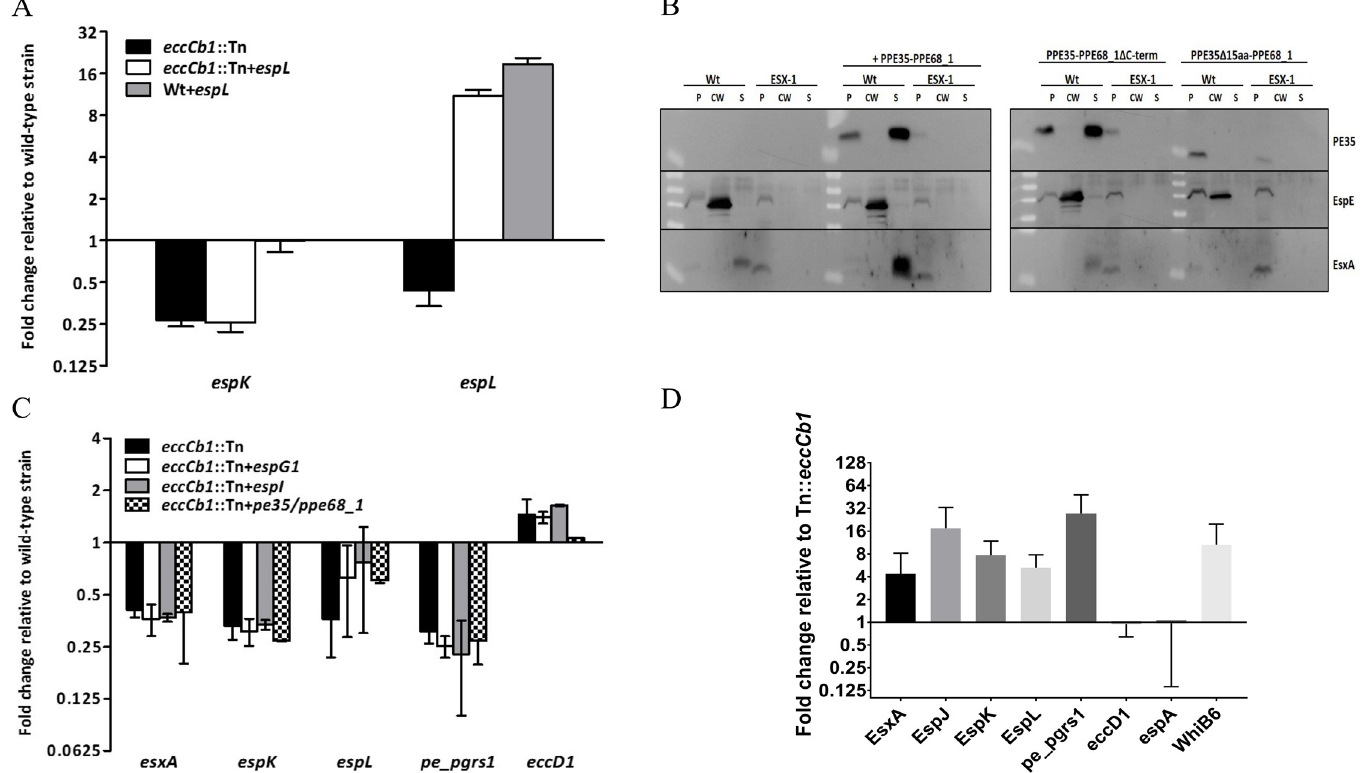
Fig 5. Regulation of the ESX-1 secretion system. (A) Down-regulation of espL is the result of a regulatory process. A functional copy of espL was introduced into wild- type and eccCb1 mutant strains of M . marinum , and the espK and espL gene expression levels were measured by qRT-PCR. Gene expression levels were compared to those of the wild-type strain E11. Values represent mean ± standard error of the mean of two biological replicates. (B) Introduction of PE35/PPE68_1 result in increased EsxA secretion but not in gene regulation. Pellet (p), cell wall extract (cw), and supernatant (s) fractions of the wild-type and eccCb1 mutant strains of M . marinum expressing PE35/PPE68_1; PE35/PPE68, containing a C-terminal deletion of PPE68_1; or PE35/PPE68_1, containing a 15-amino-acid C-terminal deletion of PE35, were analysed for the presence of EspE, EsxA and the introduced PE35 by immunoblotting. Fractions represent 0.5, 1 or 2 OD units of original culture. In all cases, PE35 contained a C- terminal HA tag. (C) EspG1, EspI and PE35/PPE68_1 do not regulate the transcription of selected esx-1 -associated genes. EspG1, EspI or PE35/PPE68_1 were overexpressed in the M . marinum eccCb1 mutant strain, and the expression levels of espK , espL , esxA , pe_pgrs1 and eccD1 were measured by qRT-PCR. Gene expression levels were compared to those of the wild-type strain E11. Values represent mean ± standard error of the mean of at least two biological replicates. (D) WhiB6 is involved in transcriptional regulation of ESX-1 substrates and associated genes. The whib6 gene was overexpressed in the M . marinum eccCb1 mutant strain, and transcript levels of espK , espL , esxA , pe_pgrs1 and eccD1 were measured by qRT-PCR. Gene expression levels were compared to those of the eccCb1 mutant strain. Values represent mean ± standard error of the mean of two biological